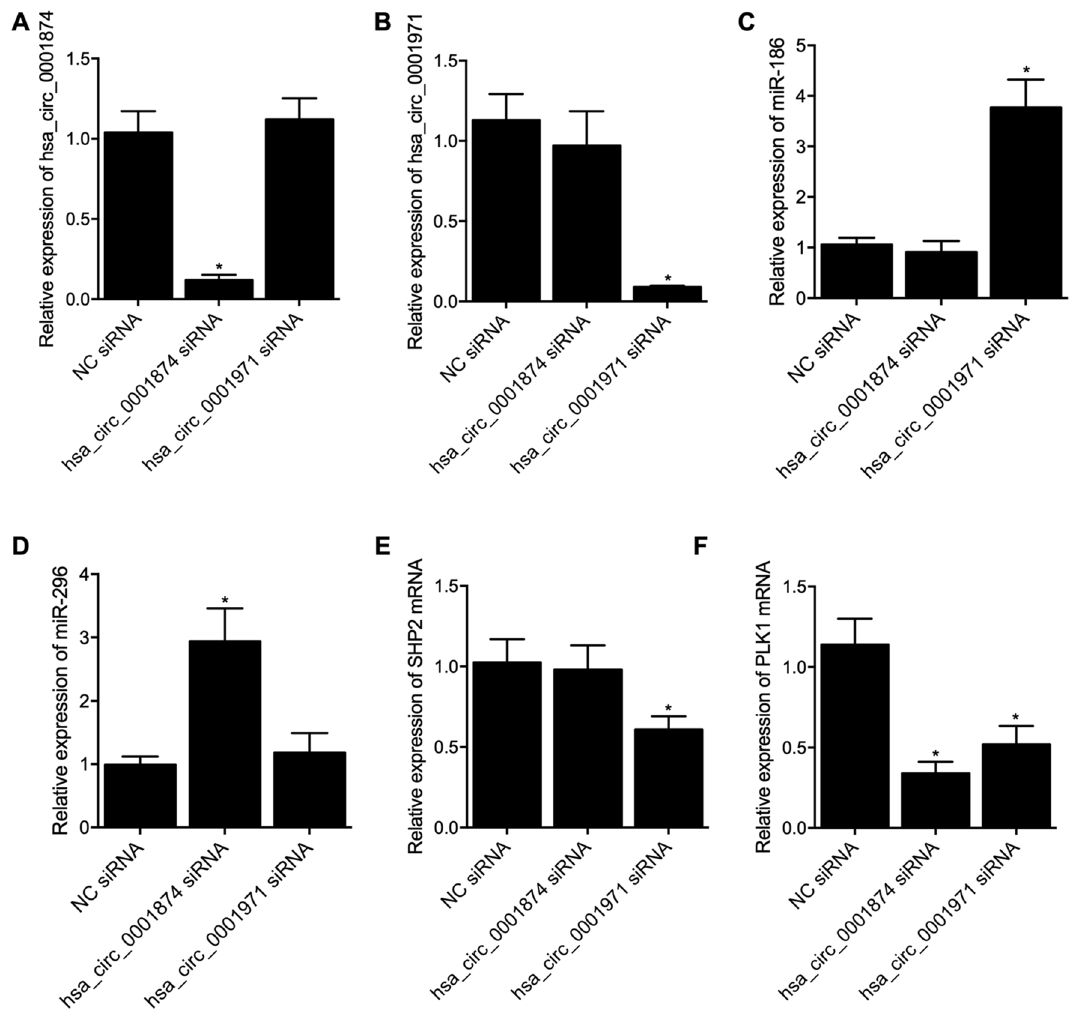
Figure 5. The knockdown of hsa_circ_0001874 and hsa_circ_0001971 up-regulated the gene expression of PLK1 and SHP2 via the regulation of miR-186 and miR-296 expression. ( A ) Relative expression of hsa_circ_0001874 was evidently suppressed by the transfection of hsa_circ_0001874 siRNA rather than the transfection of hsa_circ_0001971 siRNA (*P value < 0.05 vs. NC siRNA group); ( B ) Relative expression of hsa_circ_0001971 was evidently suppressed by the transfection of hsa_circ_0001971 siRNA rather than the transfection of hsa_circ_0001874 siRNA (*P value < 0.05 vs. NC siRNA group); ( C ) Relative expression of miR-186 was significantly elevated by the transfection of hsa_circ_0001971 siRNA rather than the transfection of hsa_circ_0001874 siRNA (*P value < 0.05 vs. NC siRNA group); ( D ) Relative expression of miR-296 was significantly elevated by the transfection of hsa_circ_0001874 siRNA rather than the transfection of hsa_circ_0001971 siRNA (*P value < 0.05 vs. NC siRNA group); ( E ) Relative expression of SHP2 mRNA was evidently inhibited in the hsa_circ_0001971 siRNA group rather than in the hsa_circ_0001874 siRNA group (*P value < 0.05 vs. NC siRNA group); ( F ) Relative expression of PLK1 mRNA was evidently inhibited in both the hsa_circ_0001874 siRNA and hsa_circ_0001971 siRNA groups (*P value < 0.05 vs. NC siRNA effect of miR-186/miR-296 overexpression, on the proliferation and apoptosis of SCC-9 cells. As shown in Fig. 7A, the OD value of the negative control cells was the lowest, while the SCC-9 cells over-expressing both circ_0001971 and circ_0001874 showed the highest proliferation rate. Meanwhile, the transfection of miR-186 or miR-206 precursors suppressed circRNA-induced proliferation of SCC-9 cells, and the co-transfection of miR-186 and miR-206 precursors most significantly reduced circRNA-induced cell proliferation. On the con- trary, the results in Fig. 7B showed that the apoptosis rate of SCC-9 cells was decreased after over-expressing circ_0001971 or circ_0001874. Compared with the NC group, circ_0001971 or/and circ_0001874 significantly suppressed cell apoptosis. The presence of miR-186 precursors and/or miR-206 precursors also increased the apoptosis of SCC-9 cells over-expressing circ_0001971 or circ_0001874. The level of miR‑186 and miR‑296‑5p was lower in saliva of OSCC patients compared with that in OLK patients. Two groups of patients were recruited in this study: A total of 135 OSCC patients were